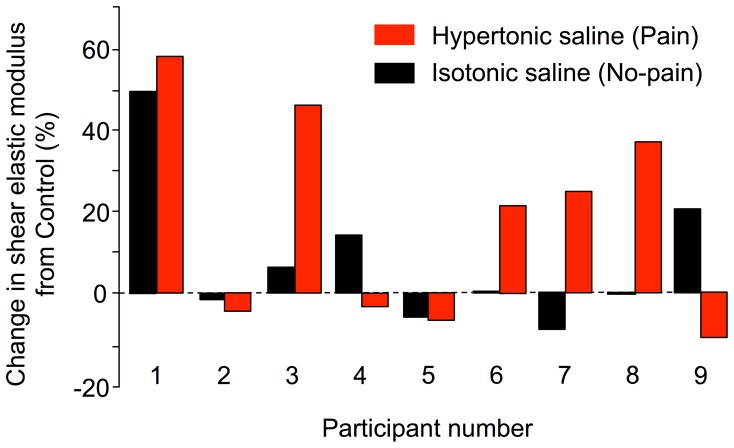
Change in shear elastic modulus from Control.Percentage of change in muscle shear elastic modulus from Control condition is depicted for both isotonic saline (No-pain: black) and hypertonic saline (Pain: red) condition. The absolute amplitude of change (not shown) was greater following the hypertonic saline injection, but whether shear elastic modulus increased or decreased differed between participants.